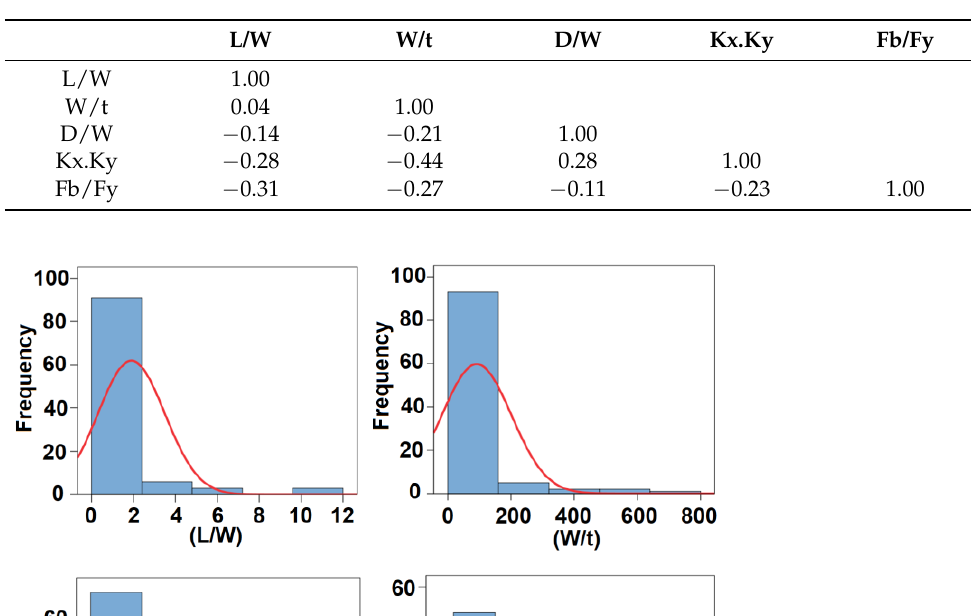
Table 2. Pearson correlation matrix.